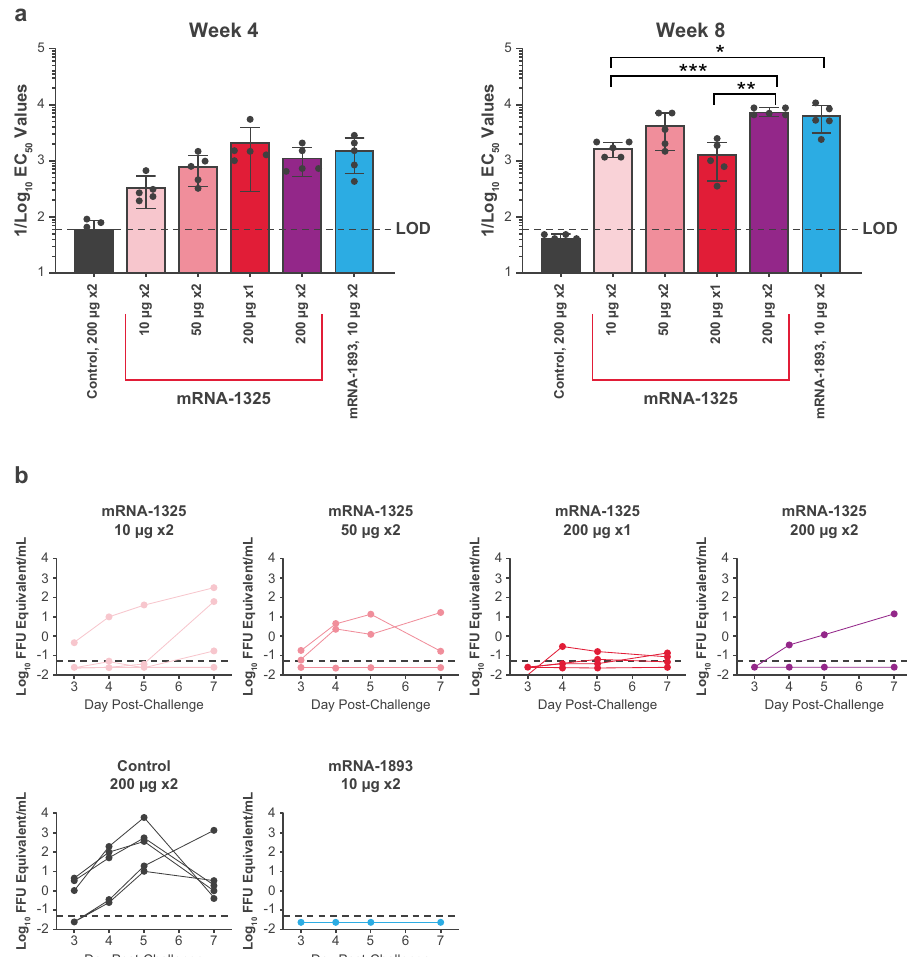
Fig. 4 nAb titers and protection of mRNA-1325 and mRNA-1893 against challenge in NHPs. a nAb titers were measured using the ZIKV RVP assay on week 4 (day 28) and week 8 (day 56). Colored bars represent GMTs for each group (mean ± SD) and black circles represent individual animals ( n = 5 per group). Dashed line indicates assay LOD. Statistical analysis was performed using one-way ANOVA. * P < 0.05, ** P < 0.005, *** P < 0.001. b Viremia was detected via qPCR on days 3, 4, 5, and 7 following challenge. Dashed line indicates assay LOD. ANOVA, analysis of variance; EC 50 , half-maximal effective concentration; FFU, focus forming units; GMT, geometric mean titer; LOD, limit of detection; nAb, neutralizing antibody; NHP, non-human primate; qPCR, quantitative polymerase chain reaction; RVP, reporter virus particle; VLP, virus-like particle; ZIKV, Zika